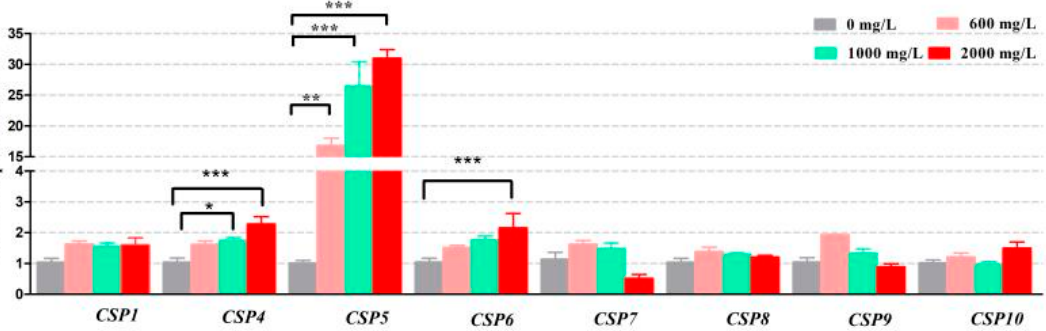
Figure 2. Effects of insecticide omethoate at different doses on CSPs expression in the cotton aphid. The results are expressed as Mean ± SEM from triplicate experiments. *, ** and *** represent p < 0.01, p < 0.001 and p < 0.0001 significant differences. The data were analysed using one-way ANOVA of Tukey’s multiple comparison test.